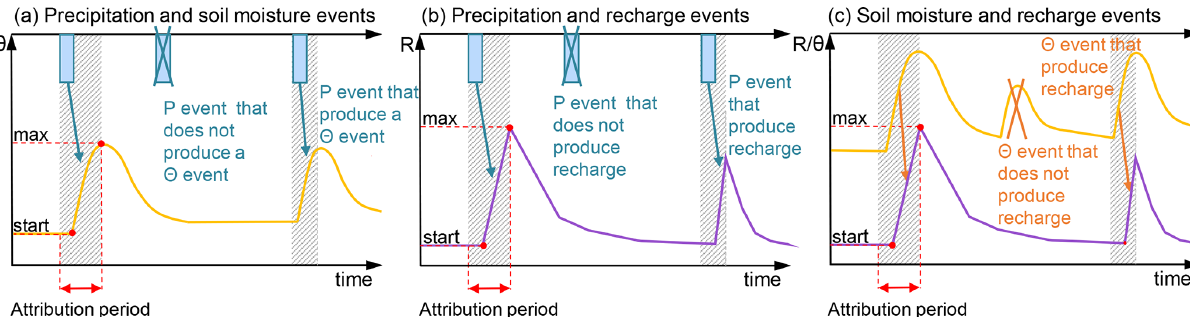
Figure 2. Event attribution method applied in this study for the attribution of precipitation events to soil moisture events (a) , for the attri- bution of precipitation events to recharge events (b) , and for the attribution of soil moisture events to recharge events (c) . (P: precipitation, R: recharge, (cid:50) : soil